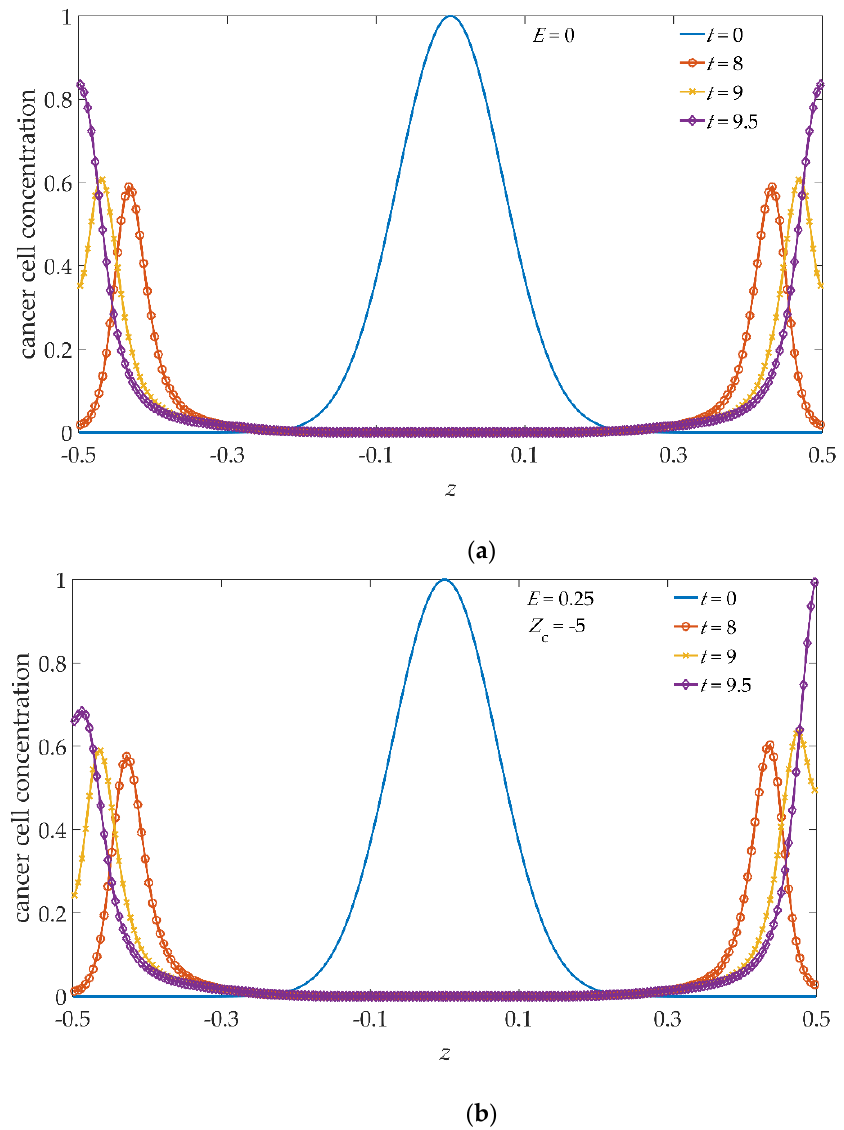
Figure 4. Profiles of the cancer cell concentration along the vertical cutline (see text). ( a ) In the absence of an applied electric field; ( b ) Applying a uniform electric field in the negative z -axis direction, with intensity E = 0.25, putting Z c = − 5. Snapshots are taken at t = 0 (blue), t = 8 (red/circle), t = 9 (yellow/cross), and t = 9.5